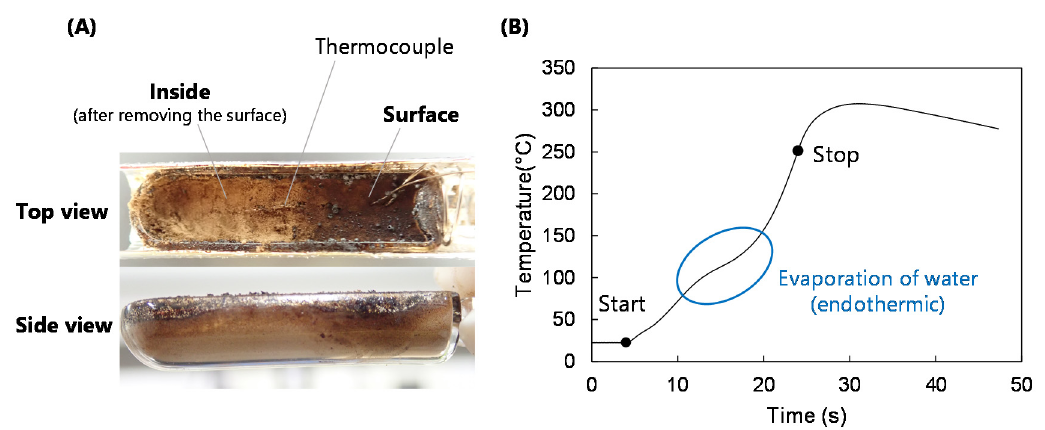
Figure 12. ( A ) Photographic images of a quartz sample boat after IR irradiation for 20 s (less than the 30 s required for complete pyrolysis of Avicel cellulose) and ( B ) the temperature inside the cellulose over time (1 kW, 5 L/min nitrogen flow).